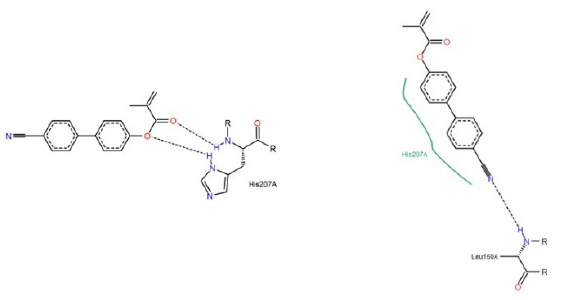
Figure A8. Interactions between compound A and MMP-8, by PoseView calculations.